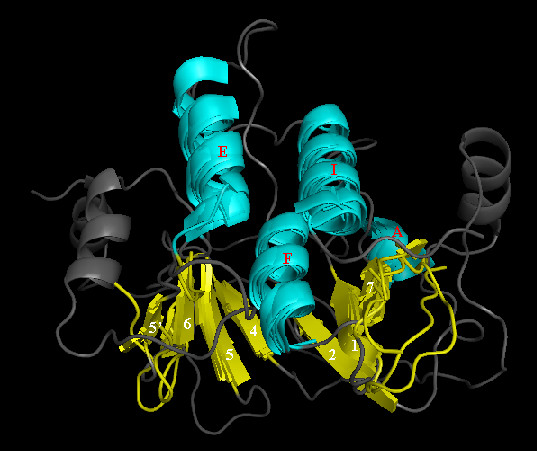
3-D rendering of the backbone traces of ST3Gal I, II, III, IV, V and VI superposed on each other using SwissPDBViewer. Helices A, E, F and I (all in cyan) and strands β1, β2, β4, β5, β5', β6 and β7 (all in yellow) superpose well on each other. Residues constituting these helices and strands are given in Figure 1. Loops and other helices/strands have different conformations in the six proteins and hence have been shown for only ST3Gal I (dark gray). PyMol was used for rendering.